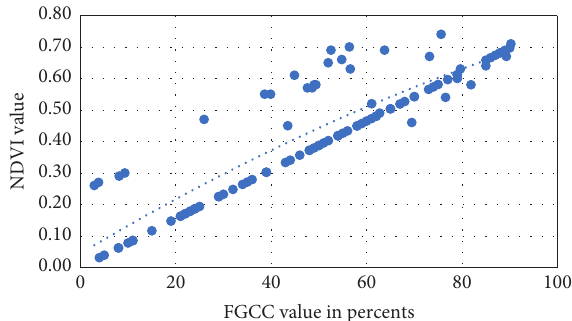
Figure 4: Approximation of the polynomial model for FGCC into NDVI conversion for millet.